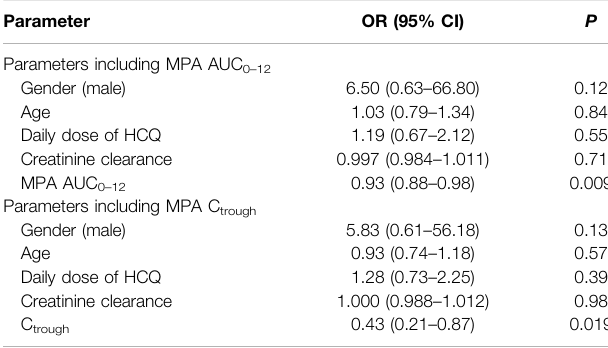
TABLE 2 | Binary logistic regression analysis of parameters potentially in fl uencing SLE activity in patients treated with MMF including MPA AUC 0 – 12 or C trough . Parameter OR (95% CI) P Parameters including MPA AUC 0 – 12 Gender